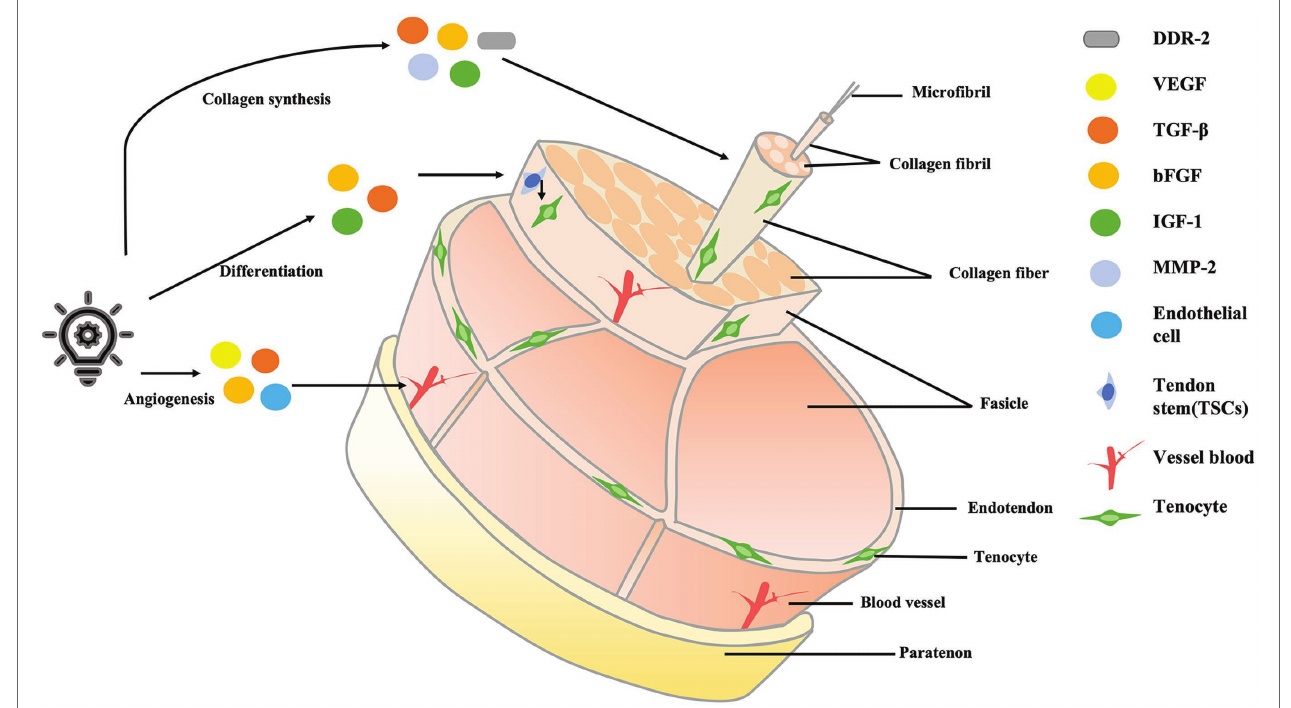
FIGURE 4 | The mechanisms of LLLT in the treatment of tendon injury. LLLT, low-level laser therapy.